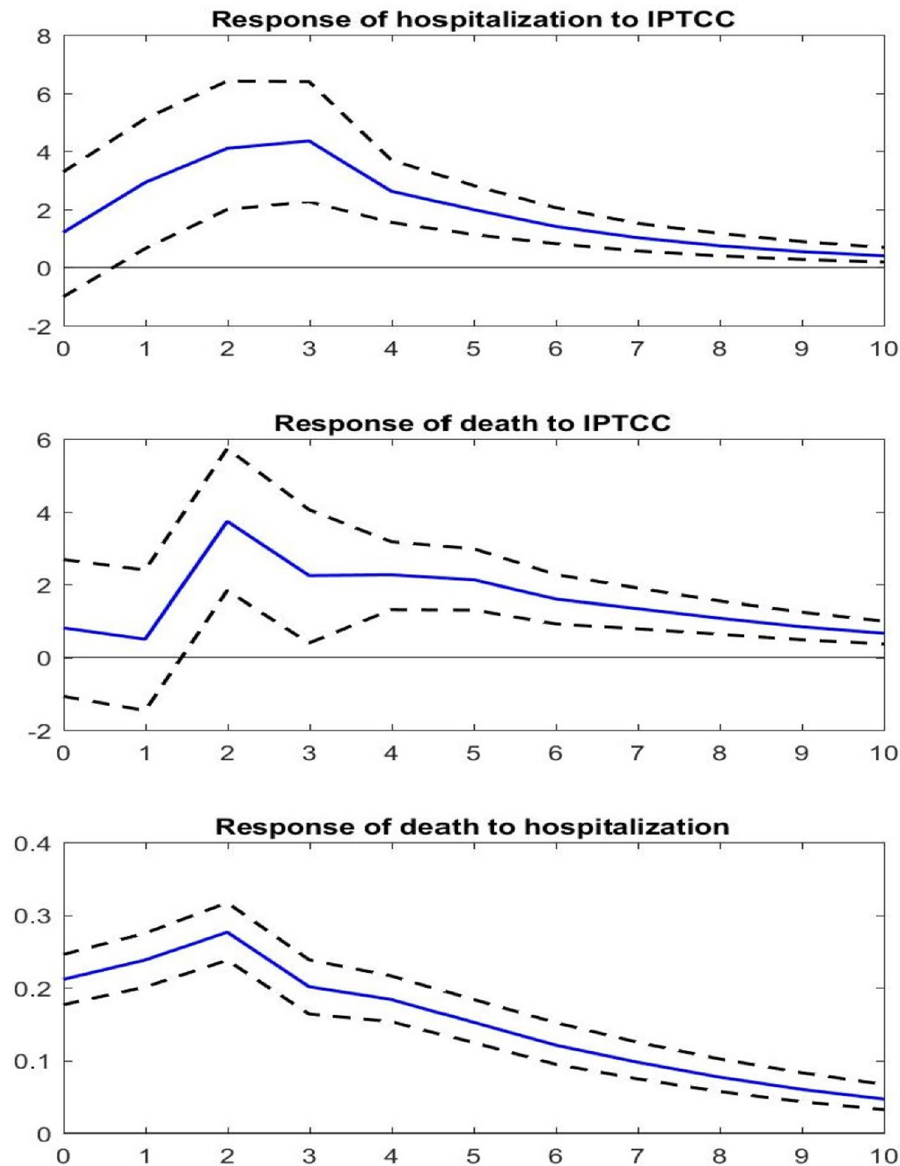
Figure 2. Dynamic responses of hospitalizations and deaths to a shock on the IPTCC. Note : The solid line gives the estimated impulse responses. The dashed lines give the 90% confidence intervals generated by Monte Carlo with 5000 repetitions. The size of the increase in the IPTCC is set to a 10-point increase. The size of the increase in hospitalizations is set to a one-percent increase. The responses are the percentage change in the number of hospitalizations and